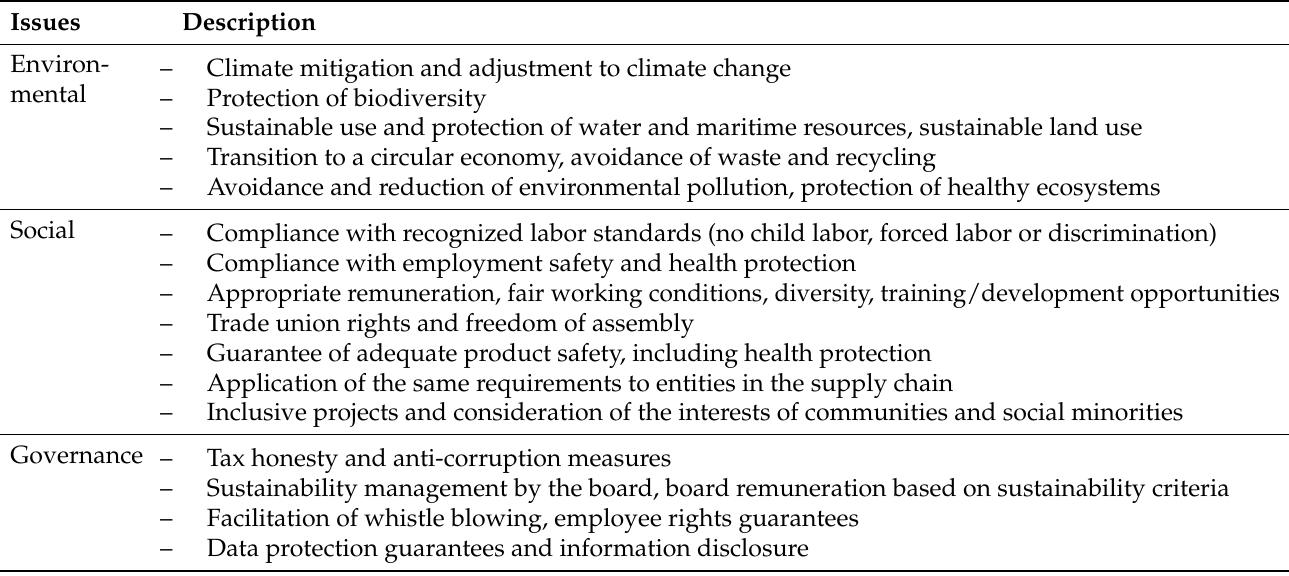
Table 3. Characterization of ESG risks (adapted from BaFin 2019; COSO and WBCSD 2018; EBA 2020; EIOPA 2019; Pfeifer and Langen